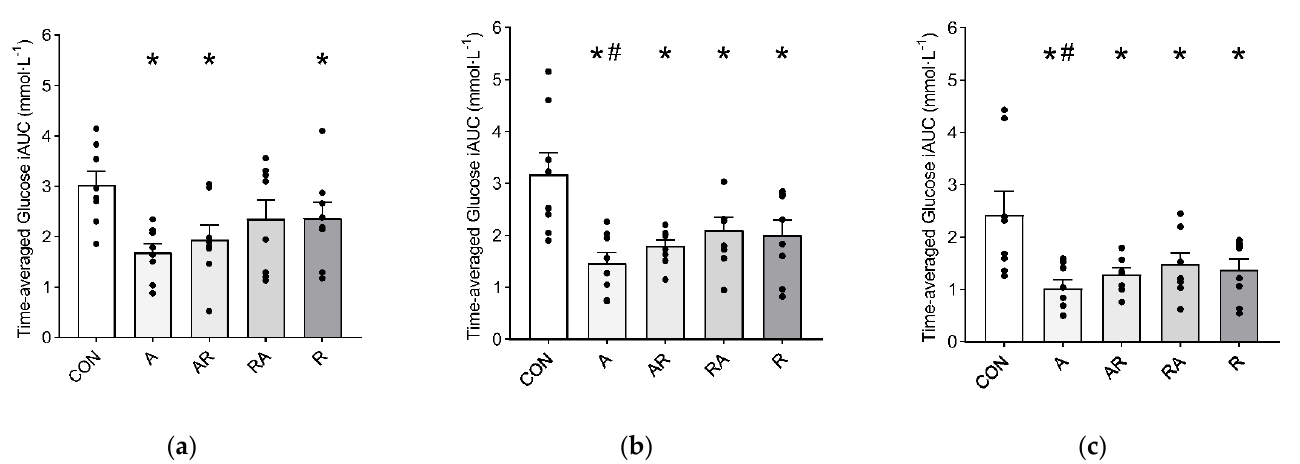
Figure 3. Time-averaged positive iAUC at: ( a ) 0–60 min; ( b ) 0–120 min; ( c ) 0–180 min. Symbols: *, P < 0.05 vs. CON; #, P < 0.05 vs. RA. Values are reported as mean (± SEM).